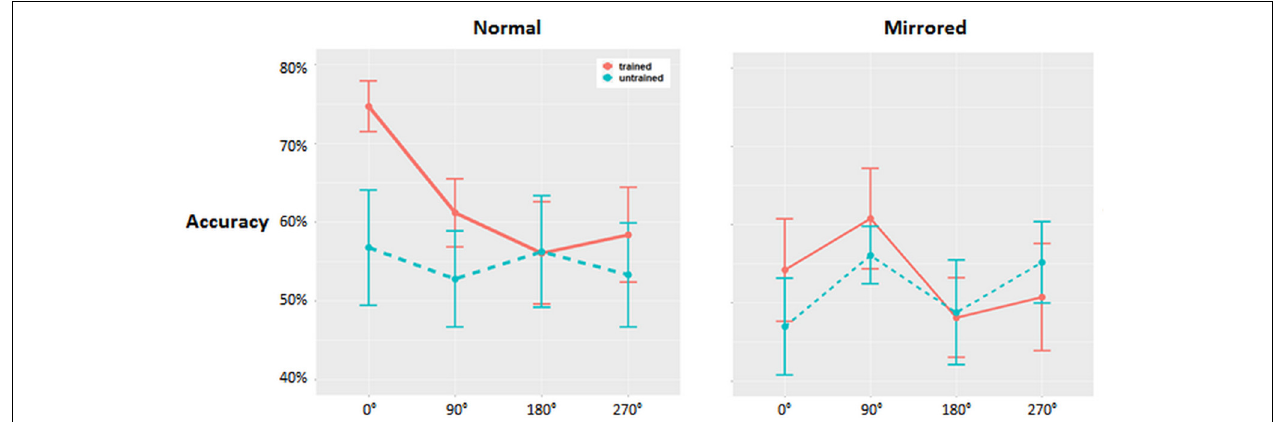
FIGURE 2 | Group-averaged ( N = 14) accuracy data for normal and mirrored stimuli (SEM indicated). The left column displays results for normal stimuli, while the right displays results for mirrored stimuli. Red lines refer to trained stimuli, while the blue lines represent untrained stimuli.